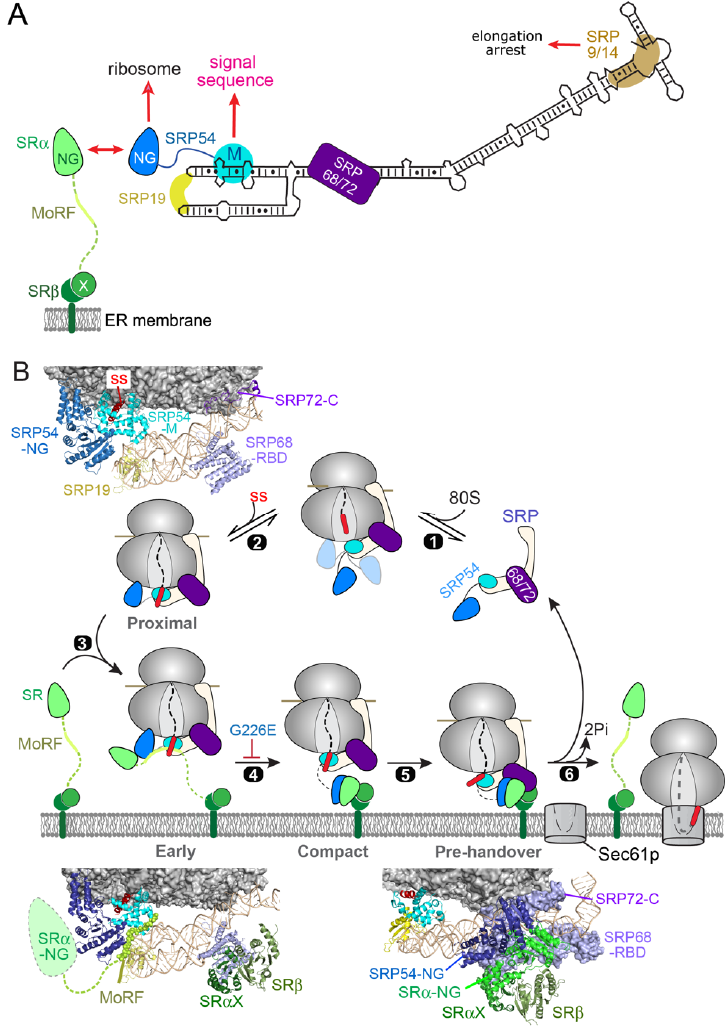
Figure 2. Model of the mammalian SRP pathway. ( A ) Schematic of the composition and interactions of the mammalian SRP and SRP receptor (SR). The individual subunits, domains, and important sequence motifs are defined in the text and indicated. MoRF, molecular recognition feature. ( B ) Current molecular model of the mammalian SRP pathway. Step 1, SRP binds to the translating ribosomes, on which it samples multiple conformations. Step 2, emergence of an ER signal sequence ( red ) drives SRP into the Proximal conformation. Step 3, early stage of SRP–SR assembly, mediated by dynamic interactions between the SRP and SR NG domains and by the SR MoRF ( lime ) interaction with SRP54. Step 4, a stable SRP/SR NG-heterodimer detaches from the ribosome exit site and docks onto the X/ β domain of SR. Step 5, the NG • X/ β complex docks onto the distal site of SRP to form the Pre-handover conformation, in which the translating ribosome is primed for handover to the Sec61p complex. Step 6, cargo is loaded on Sec61p to initiate protein translocation, and GTP hydrolysis drives the detachment of SRP from SR. The insets show the structural models of the RNC-SRP complex (PDB: 7OBR, upper left), the early RNC-SRP–SR complex (PDB: 7NFX, lower left), and RNC-SRP–SR pre-handover complex (PDB: 6FRK, lower right). Dashed outline in the early complex structure depicts SR α -NG that dynamically interacts with SRP54-NG at this stage and was not resolved in the structure. The M- and NG-domains of SRP54 are in cyan and dark blue , respectively; signal sequence (ss) is in red; SRP19 is in yellow , SRP68/72 is in purple , SRP RNA is in tan , SR α NG, SR α X, and SR β are in light green , dark green , and mustard , respectively; MoRF in the SR linker is highlighted in spacefill model in lime